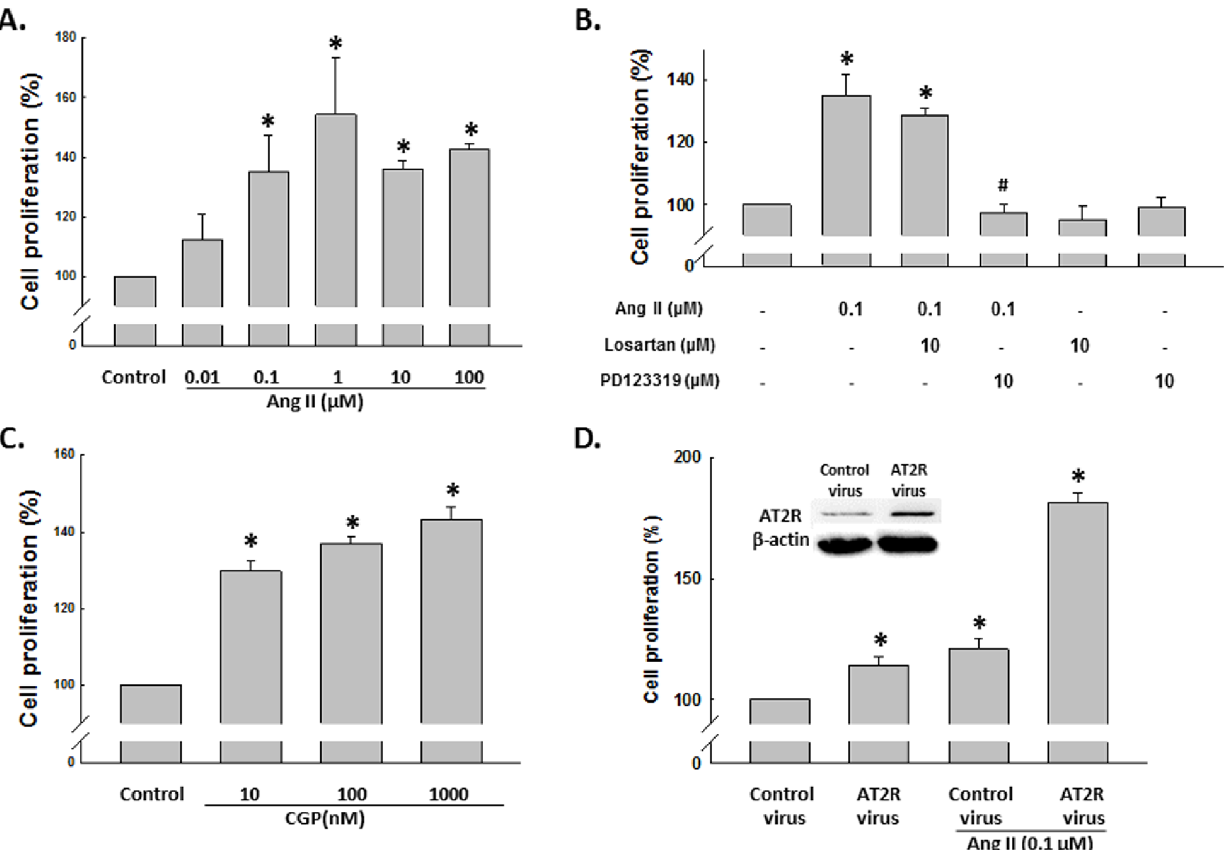
Figure 1. Effect of Ang II on NSC proliferation. A) Ang II (0.01, 0.1, 1, 10 and 100 m M) increased NSC proliferation in a concentration-dependent manner. NSCs were treated with different concentrations of Ang II for 48 hours followed by CyQUANT assay. B) The blockade of AT1R and AT2R on NSCs proliferation. Cells were pretreated with specific antagonist to AT1R or AT2R for 1 hour followed by treatment with Ang II for another 48 hours. Cell proliferation was assessed by CyQUANT assay. C) CGP42112A (10, 100 and 1000 nM) induced increase of NSC proliferation in a concentration- dependent manner. NSCs were treated with different concentrations of CGP42112A for 48 hours followed by CyQuant assay. D) Effect of AT2R overexpression on NSC proliferation. AT2R expression in NSCs transduced with control virus and AT2R virus for 72 hours as shown in the inset. *P , 0.05 vs control, # P , 0.05 vs Ang II-treated group, n=5 in each group.